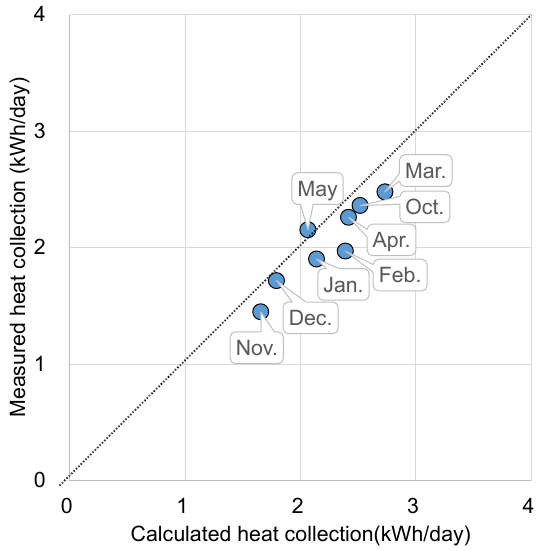
Figure 11. Relationship between heat collection and ventilation load in simulation.